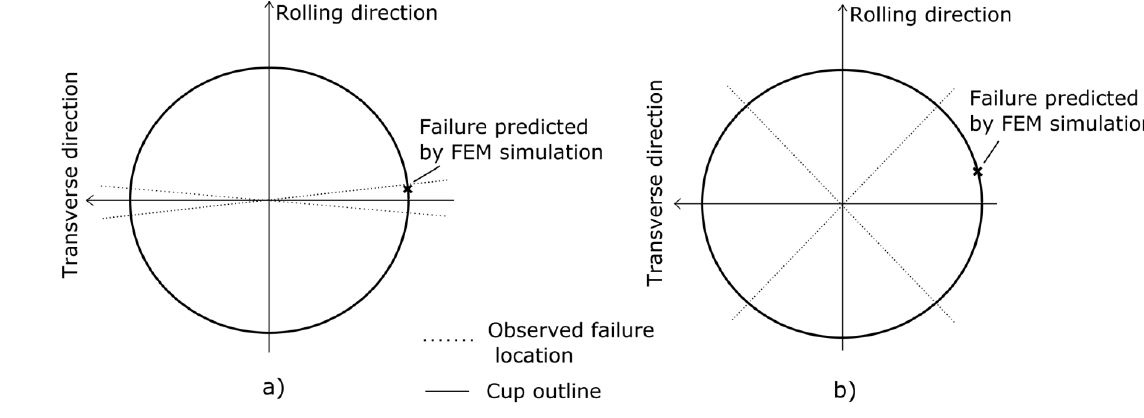
Figure 11: Failure position for AA5352 (a) and TH330 (b)